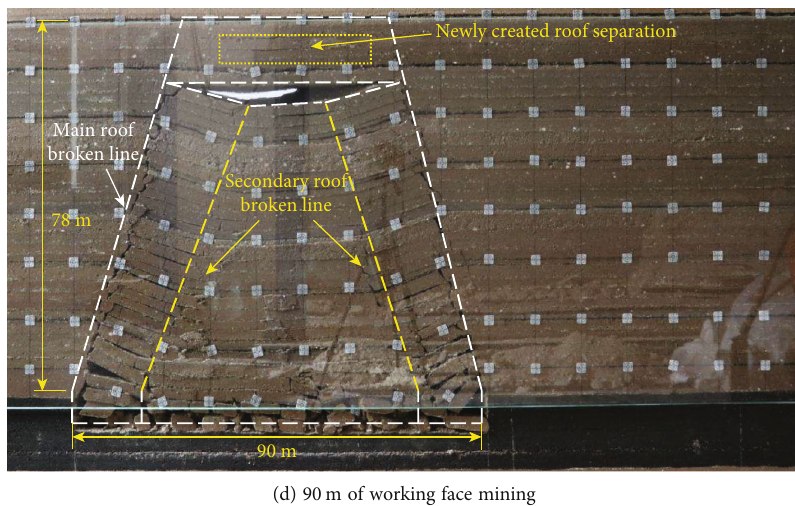
Figure 8: Evolution of overburden structure in secondary working face of 010202